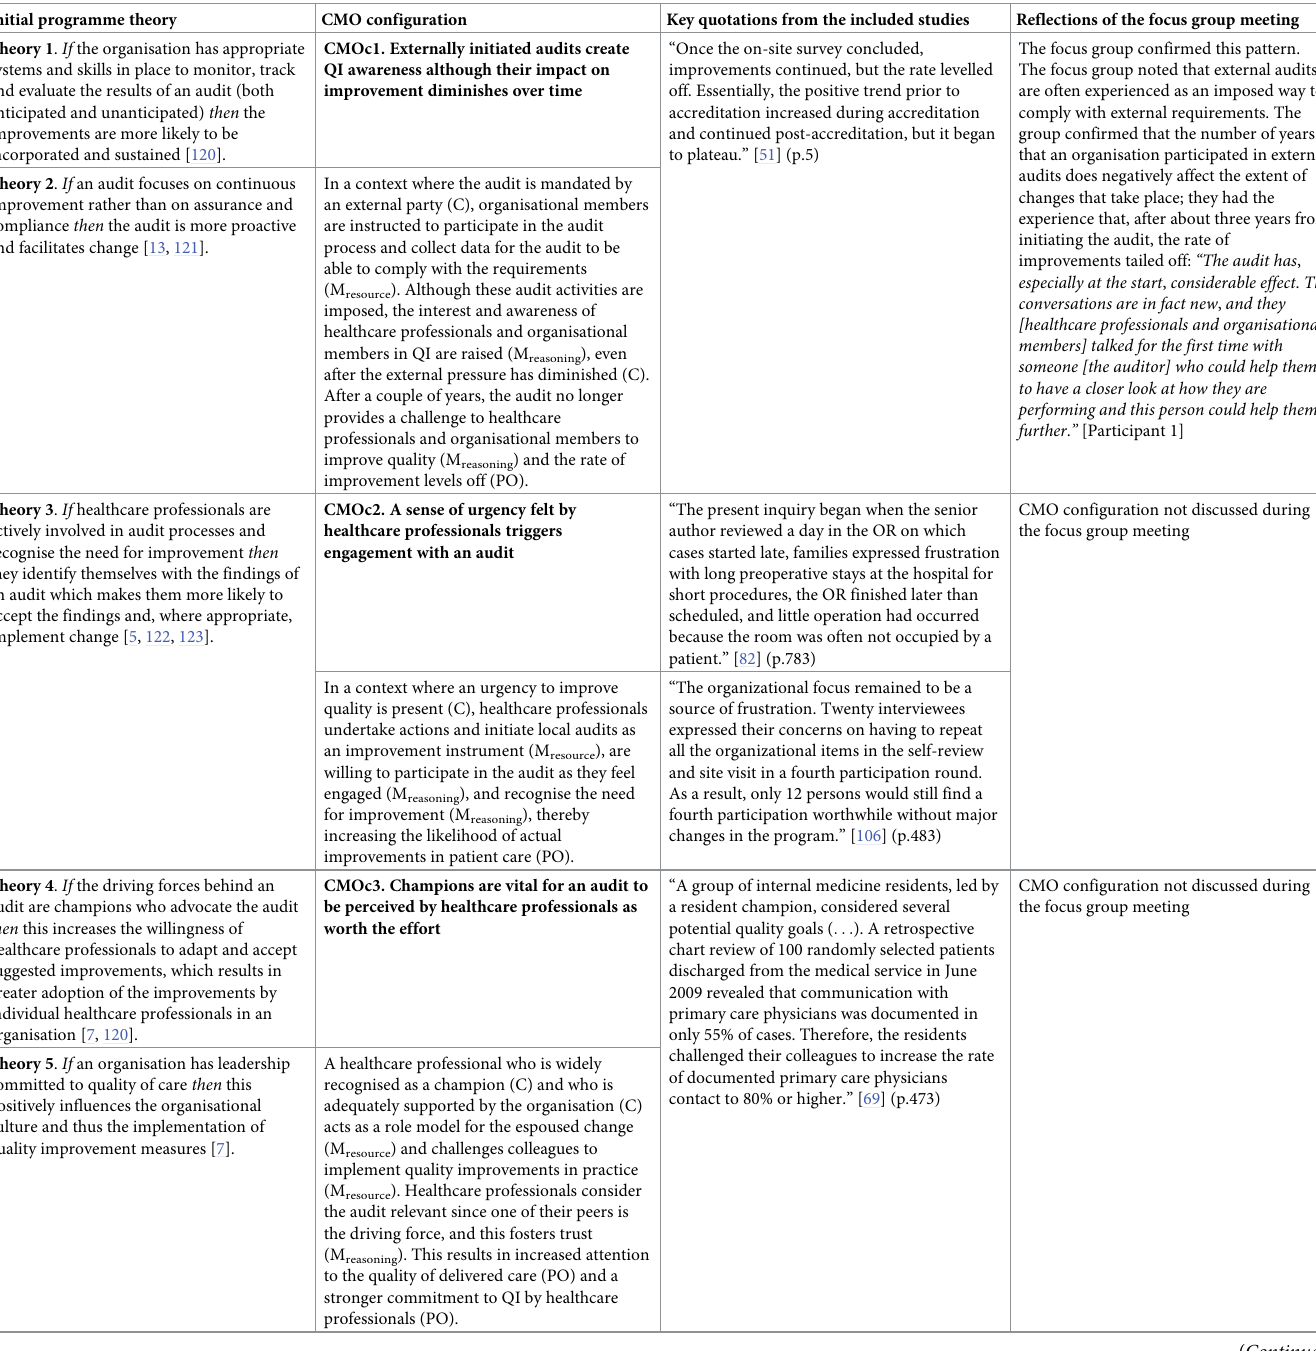
Table 3. Key findings. Initial programme theory in the form of ‘If-Then’ statements in relation to the CMO configurations (observed associations), key quotations and reflections of the focus group